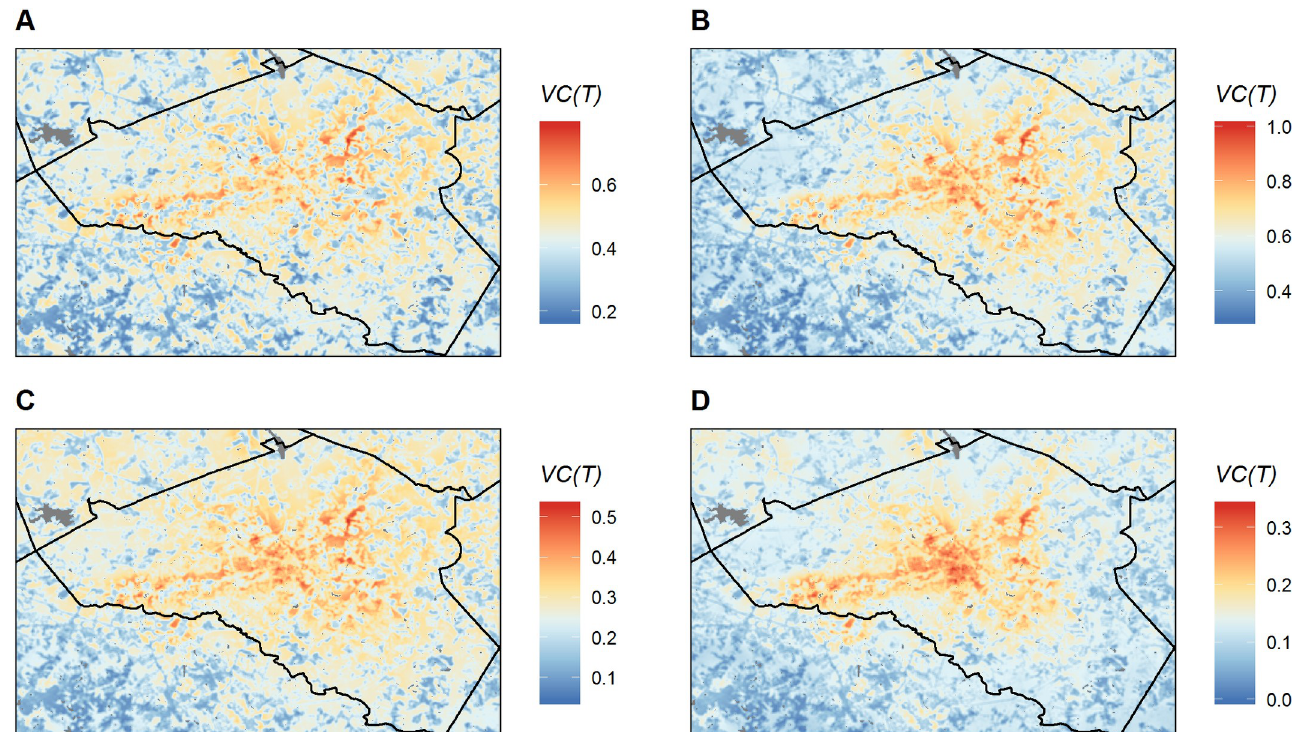
Fig 7. Maps of temperature-dependent vectorial capacity ( VC(T) ) for Athens-Clarke County, GA during four monthly periods in 2018. A) June-July. B) July-August. C) August-September. D) September-October. Note that a different range of VC(T) is represented in each map. Gray patches represent water bodies. The maps were produced using R version